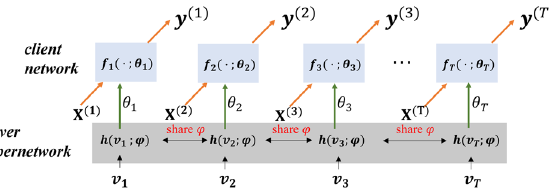
Figure 2. Hypernetwork at the server site share information across local sites implicitly through parameters ϕ , while generating each local parameter θ i of the network with respect to embedding vector v i .